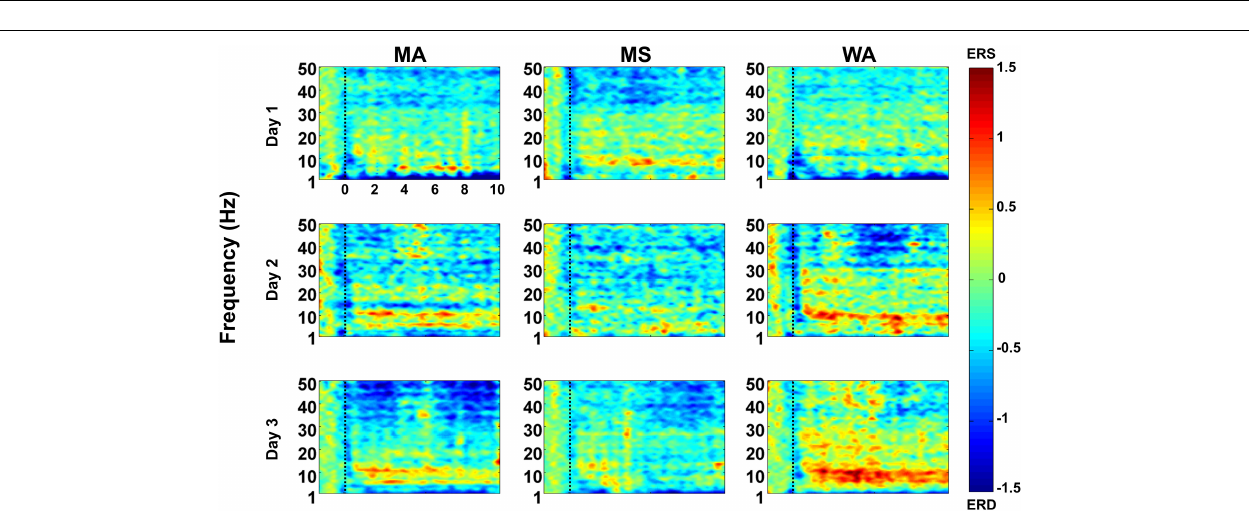
FIGURE 3 | Mean classification accuracies of the offline experiment (day 1) and the two online experiments (days 2 and 3). The mean offline classification accuracy was obtained by averaging the offline classification accuracies for the best pairs of mental tasks for each subject (day 1). The mean classification accuracies of day 3 were obtained using three different training data sets (day 2, day 3, and day 2 + day 3). An asterisk indicates a statistically significant difference.